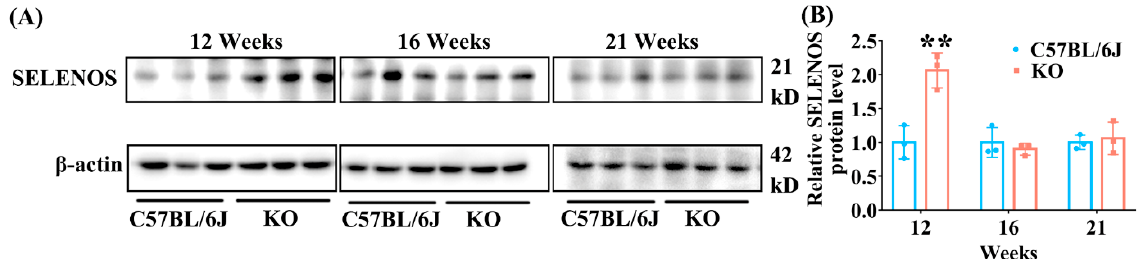
Figure 8. The expression of hepatic SELENOS in KO and C57BL/6J mice of different ages. ( A ) Representative Western blot bands of SELENOS. ( B ) Semi-quantification analysis of SELENOS to β -actin. Data were expressed as mean ± SD ( n = 3). SELENOS: Selenoprotein S. ** p < 0.01, compared with C57BL/6J mice.